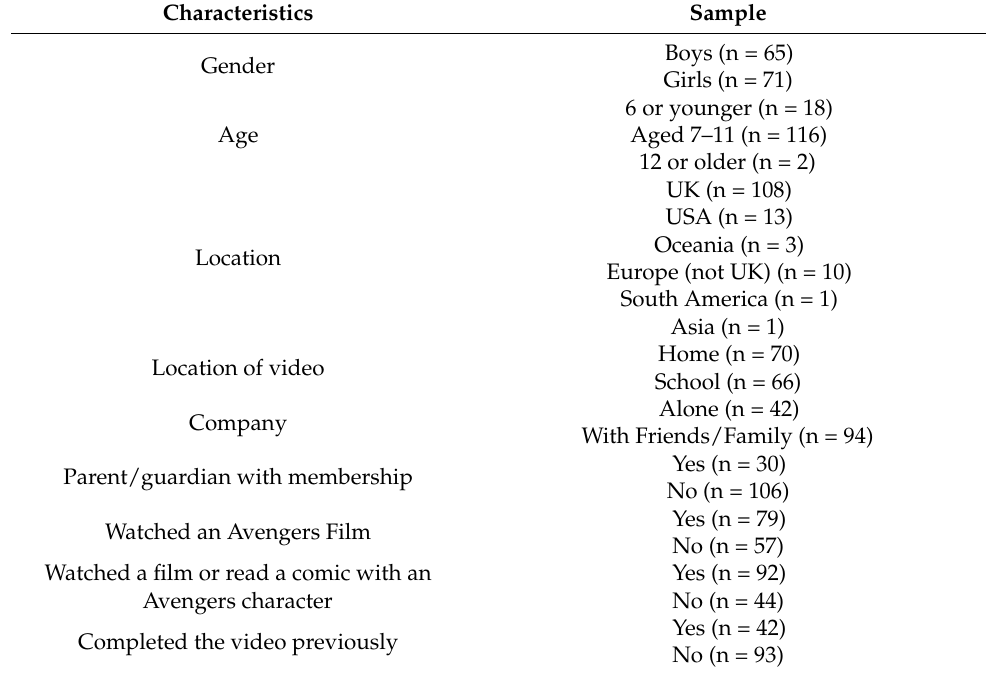
Table 1. Participant